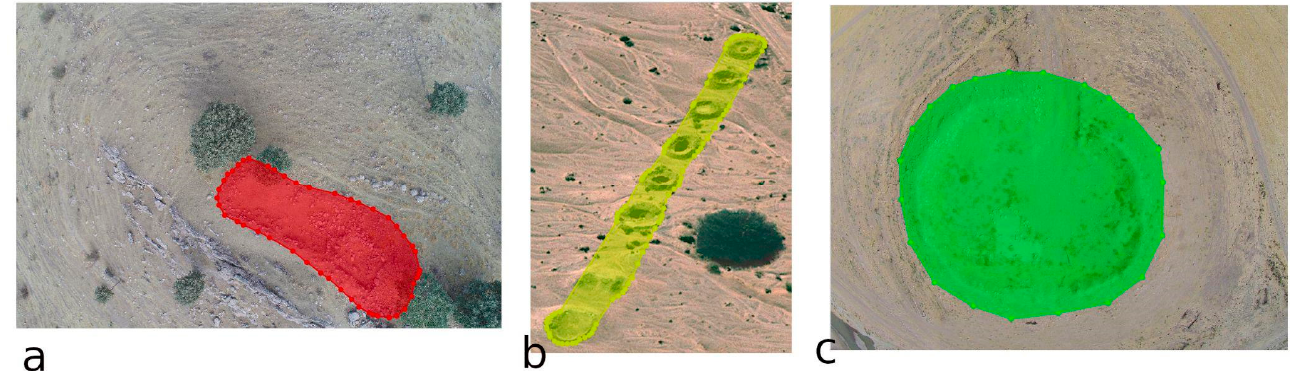
Figure 3. The three categories, that is ‘ruined structure’ ( a ), ‘ qanat’ ( b ), and ‘mounded sites’ ( c ), annotated using LabelMe via our developed tool.